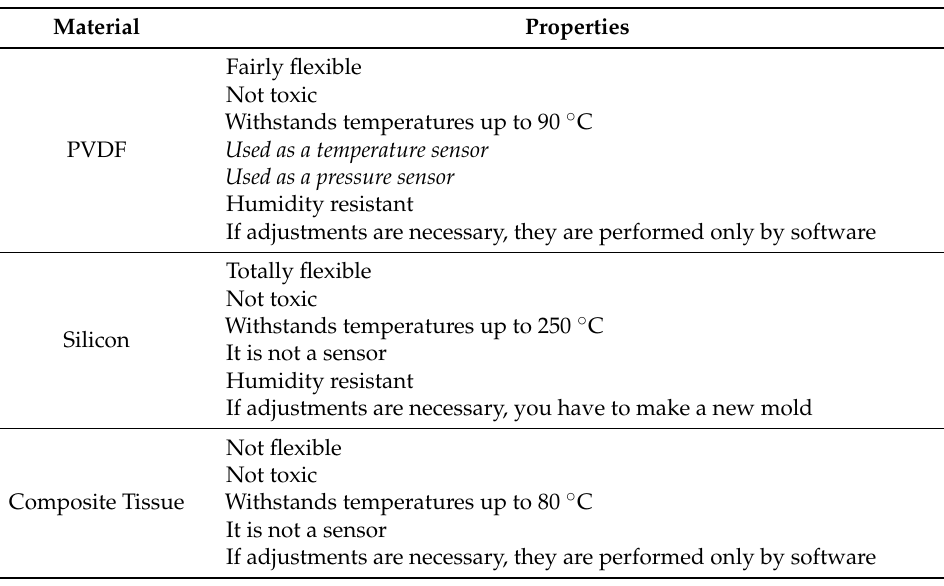
Table 2. Comparative analysis of materials used in